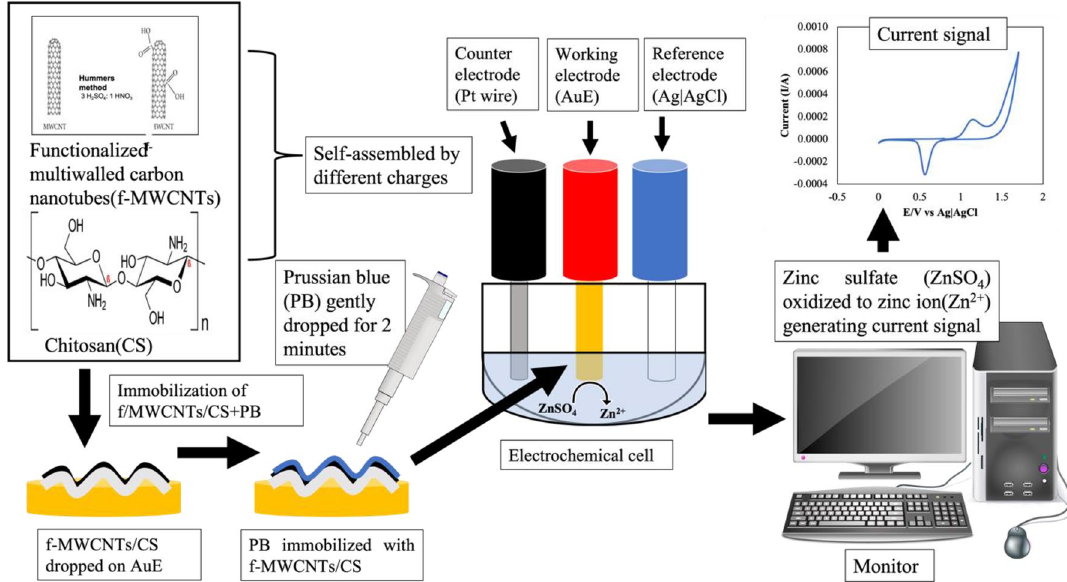
Figure 1. Schematic of the experiment for detection of zinc ion using electrochemical